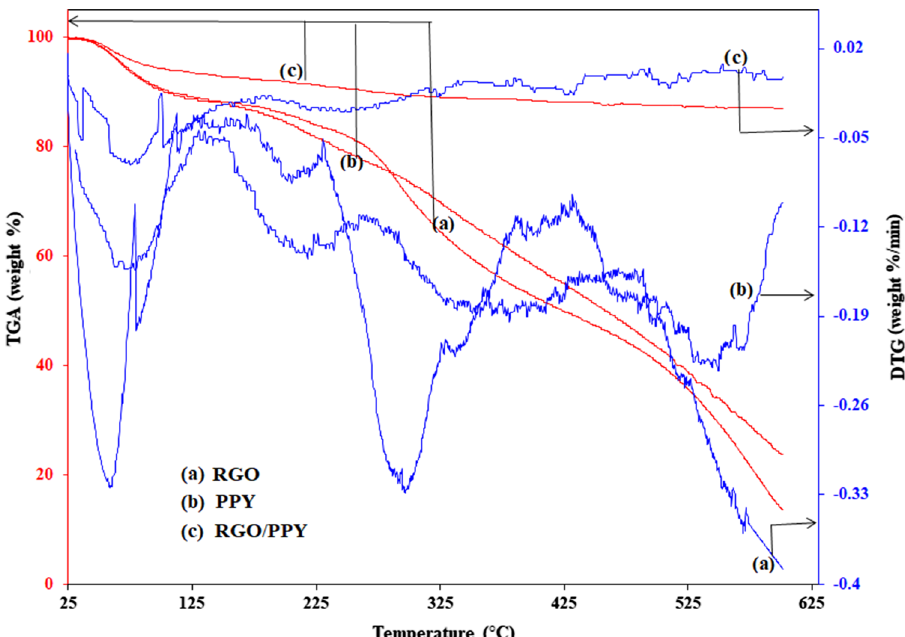
Fig. 4 TGA and DTG curves of RGO, PPy and RGO/PPy